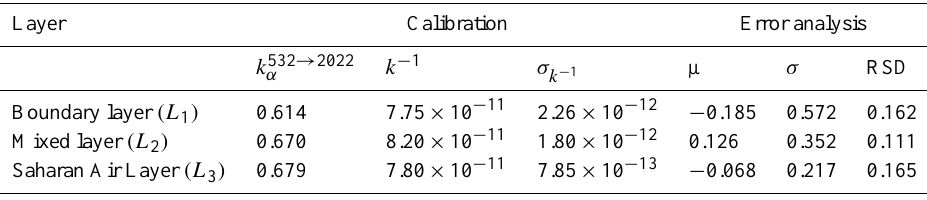
Table 3. Extinction coefficient conversion factor k 532 → 2022 α , inverse of the calibration constants k − 1 and its corresponding standard devi- ation σ k − 1 retrieved for each layer. The mean µ [Mmsr − 1 ] and the standard deviation σ [Mmsr − 1 ] of the difference between the retrieved backscatter coefficient from the DWL and POLIS are also shown together with the relative standard deviation ( σ/µ POLIS ) .